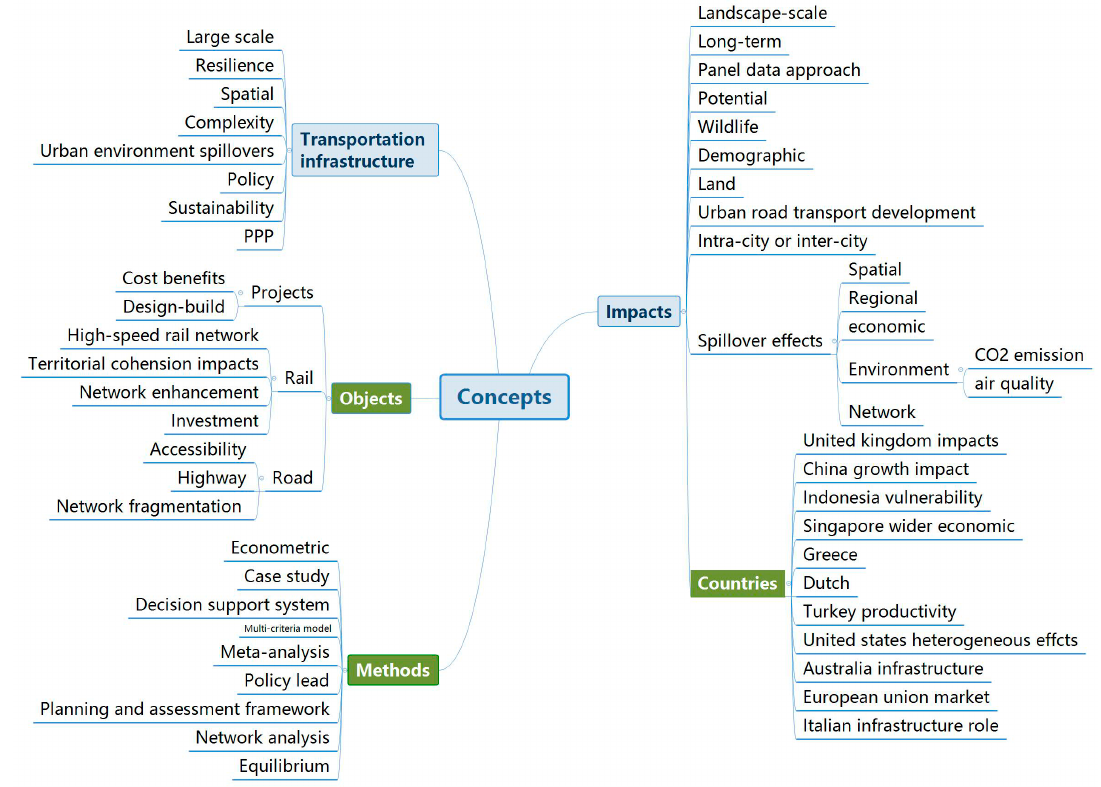
Figure 14. A hierarchy of key concepts in Cluster #0–#6.